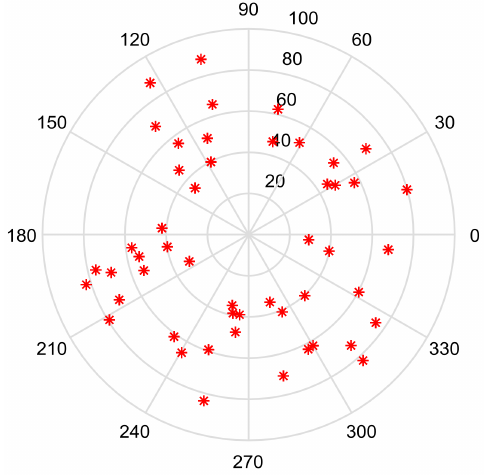
Figure 3. Star map distribution of the